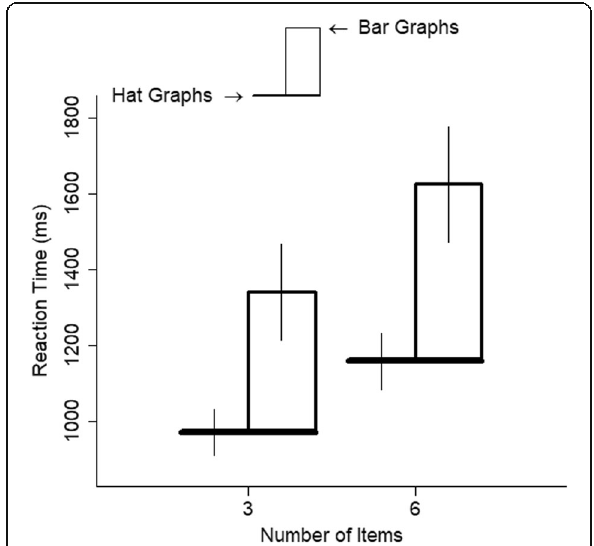
Fig. 7 Reaction time (RT) is plotted as a function of number of items and graph type for experiment 2. The brim of the hat corresponds to the RTs for the hat graph condition, and the top of the crown of the hat corresponds to RTs for the bar graph condition. The size of the crown indicates the difference in RTs between the two conditions.